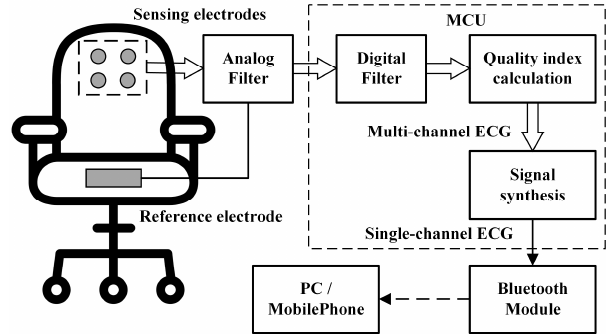
Figure 5. Systemic diagram.